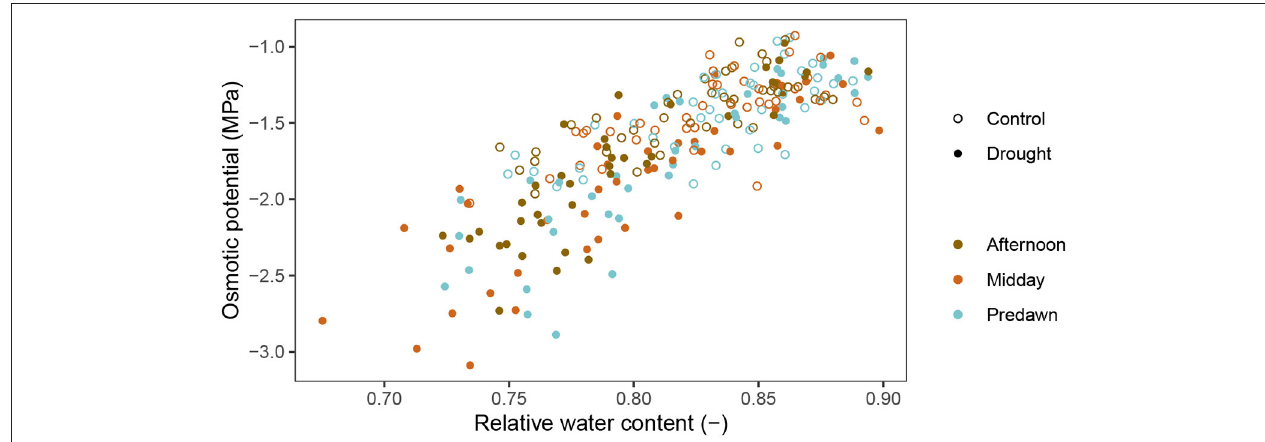
FIGURE 4 | Relation between the osmotic potential and relative water content in the stems of wheat plants. The control treatment is represented by open circles while the drought treatment by full circles. Different colors represent different timeslots during the day.